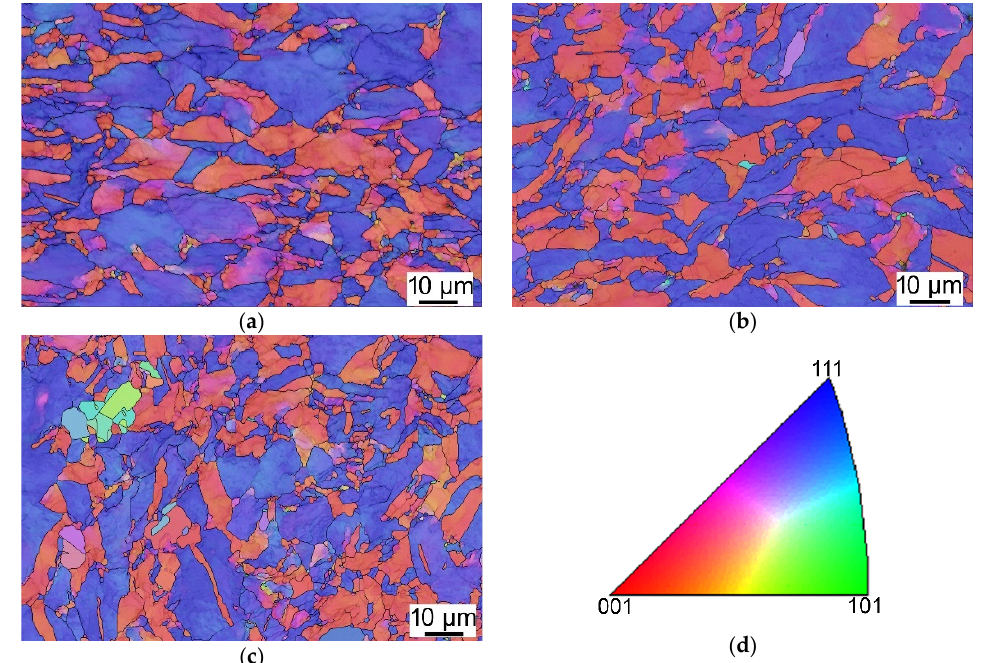
Figure 6. SEM OIM images for Cu lamellas of swaged laminate ( a ); HT1 laminate ( b ); HT2 laminate ( c ); OIM legend ( d ).